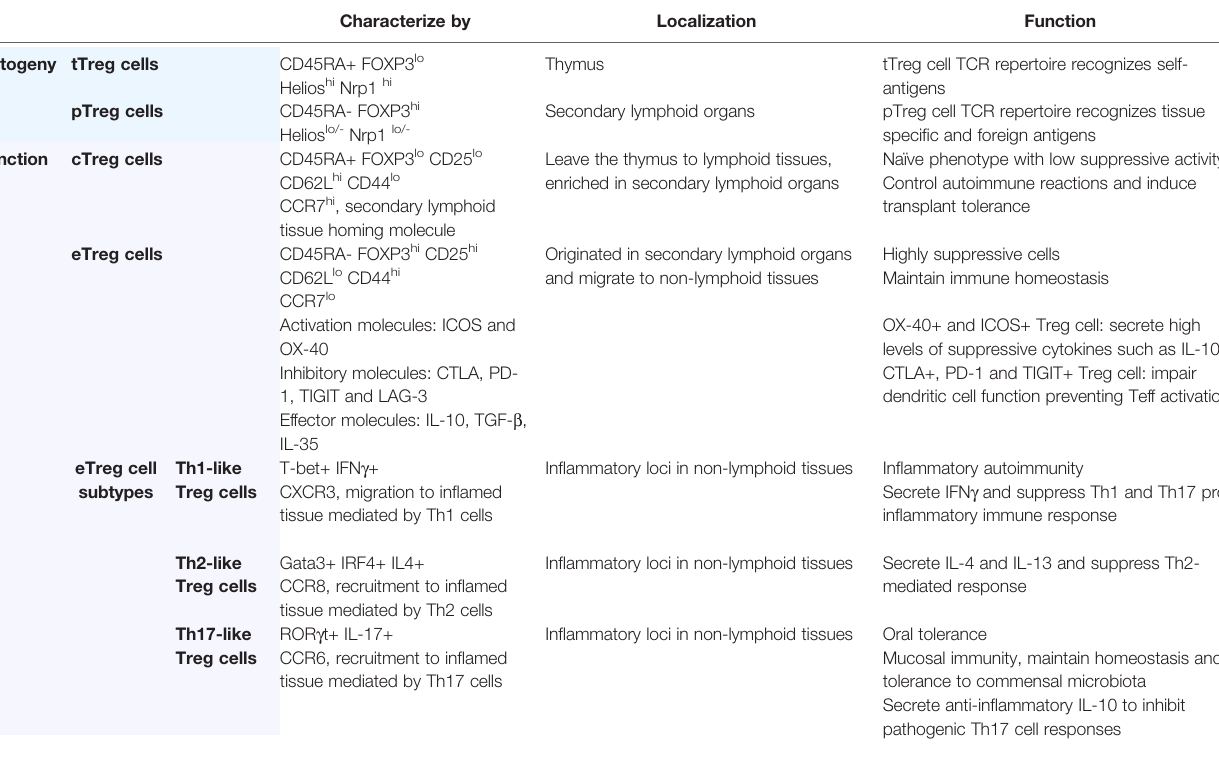
TABLE 1 | Treg cells subtypes.